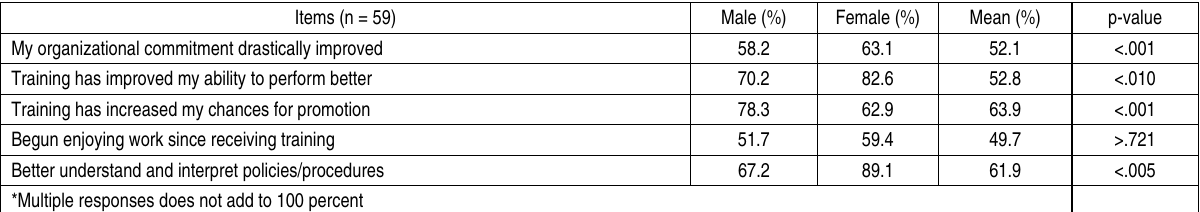
Table 5 (cont.). T-test results for gender